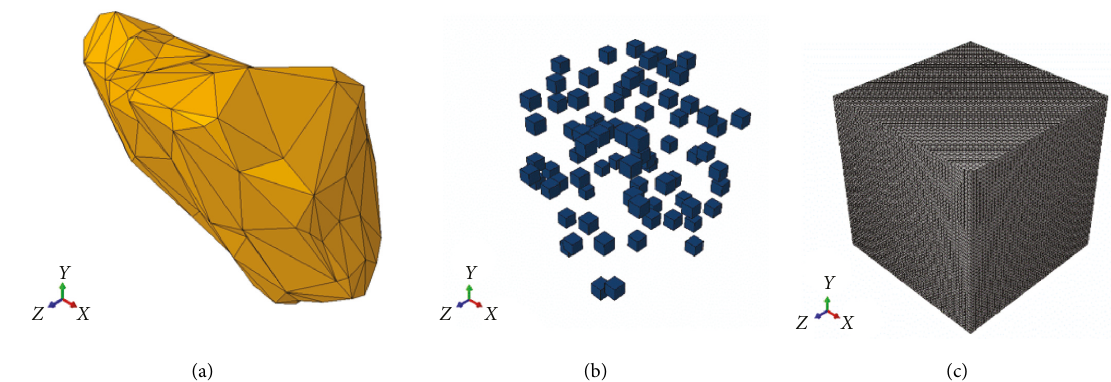
Figure 3: Finite element model of rubberized concrete. (a) Typical aggregate, (b) rubber, (c) motar.